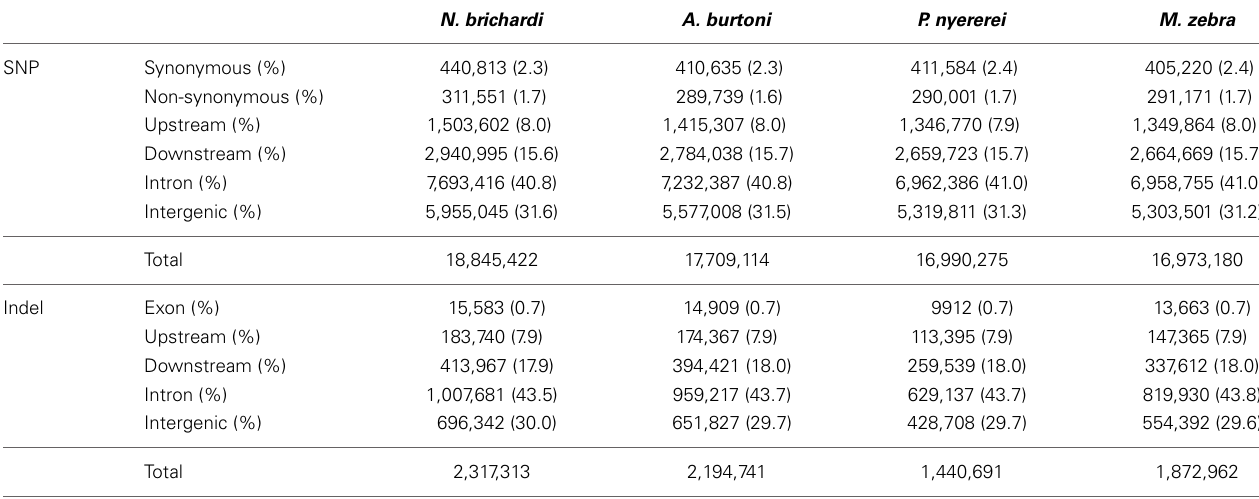
Table 1 | Summary of the SNPs and indels in the African cichlid